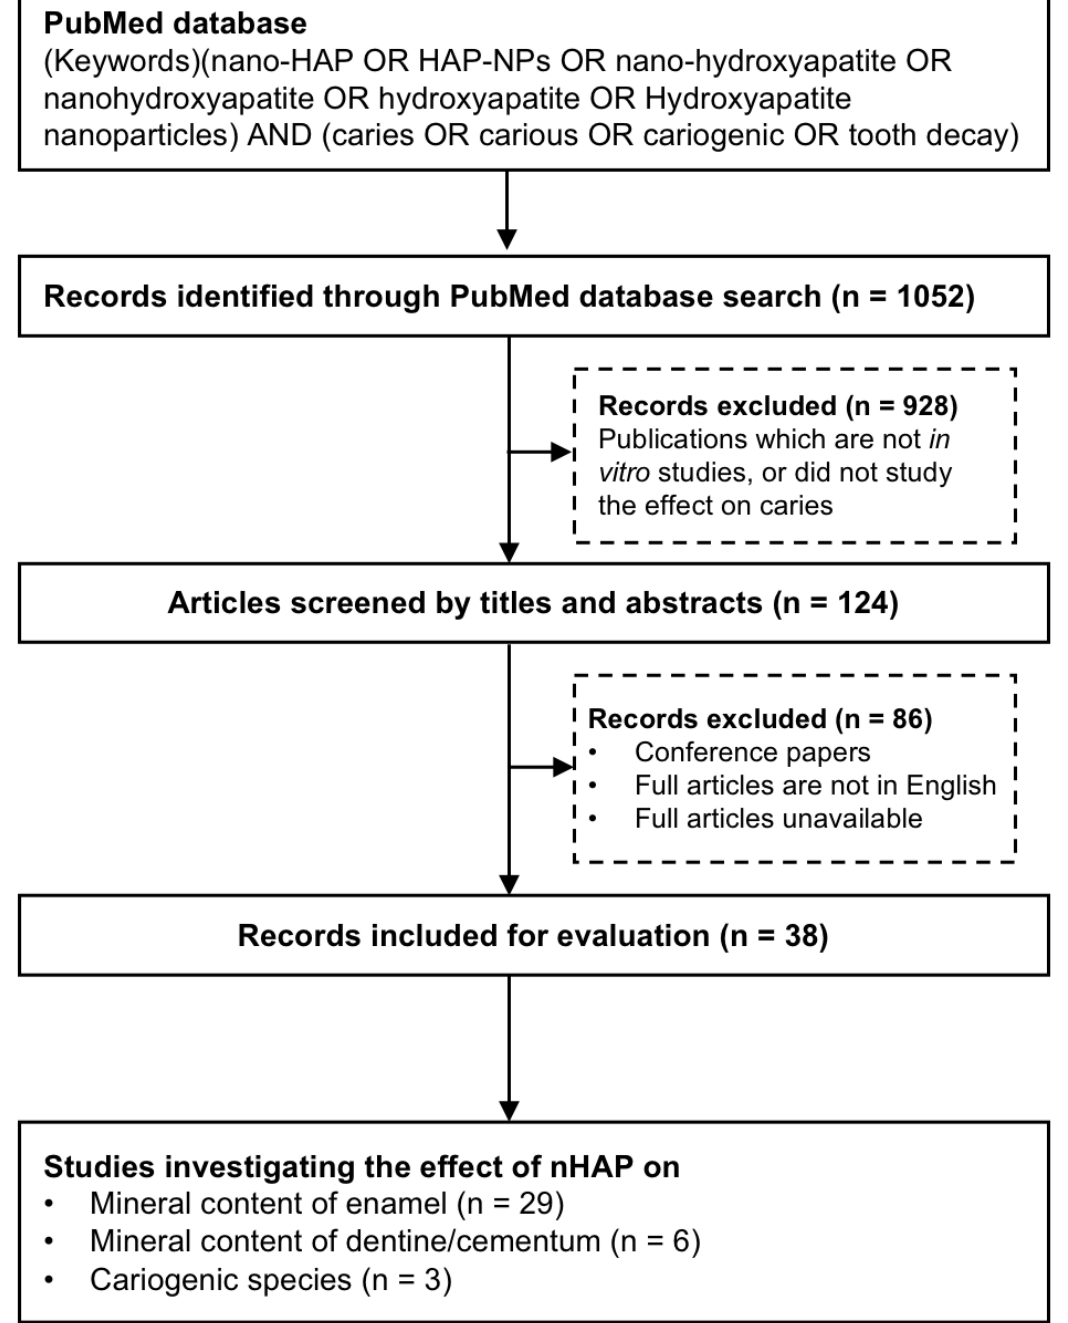
Figure 1. Flowchart of study selection process for final review.